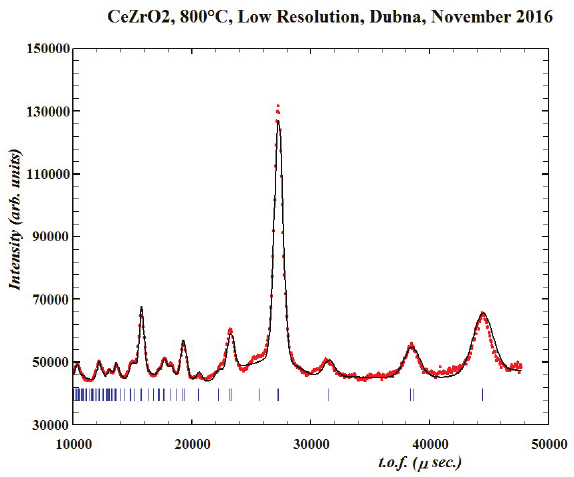
Figure 2: Experimental neutron diffraction pattern (points) and its fitting (solid line) for Ce